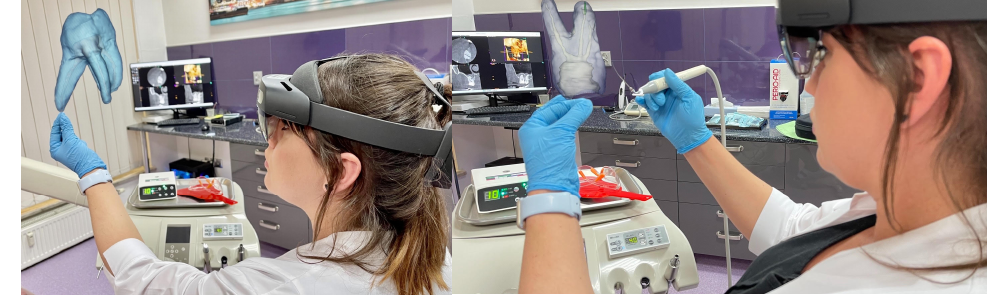
Figure 4. The MR-based supporting system for root canal treatment.